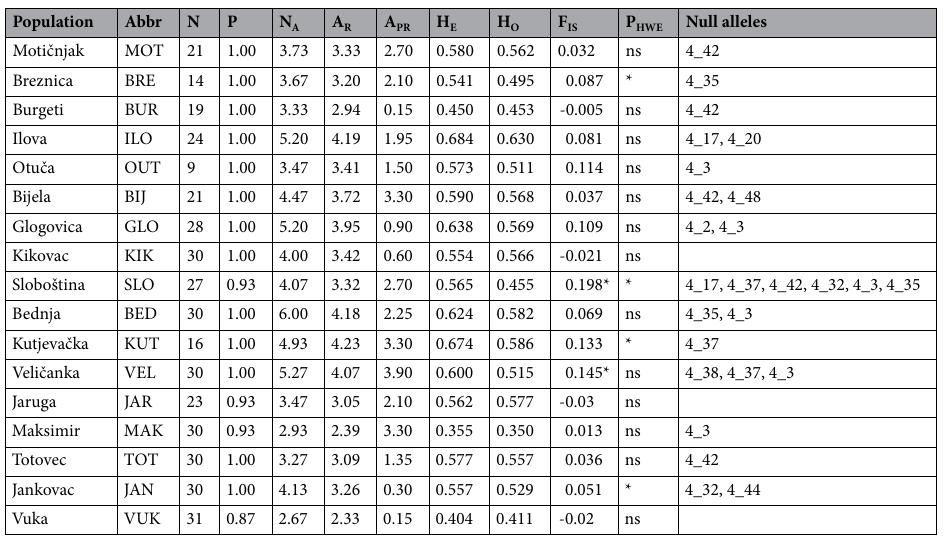
Table 1. Summarizing results across 15 microsatellite loci of population genetic diversity of studied A. astacus populations (N number of specimens, P proportion of polymorphic loci, N A average number of alleles/ locus, A R allelic richness, A PR rarefied number of private alleles, H E expected heterozygosity, H O observed heterozygosity, F IS inbreeding coefficient and P HWE probability of deviation from Hardy–Weinberg equilibrium after Bonferroni adjustments (not significant (ns) or significant (*)), null alleles—loci showing null alleles. Reference populations from Gross et al. (2021): JAR, MAK, TOT, JAN,